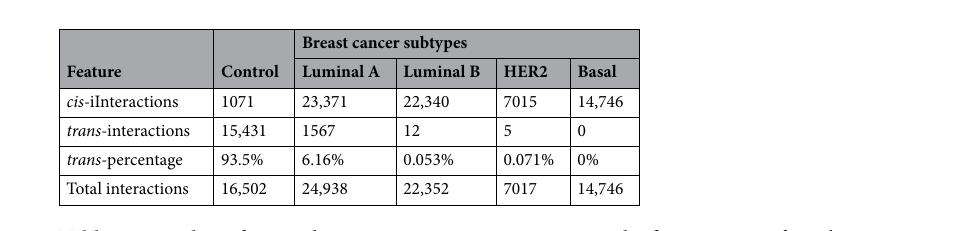
Table 3. Number of cis- and trans- gene– gene interactions in the five 30-cores of top-layer